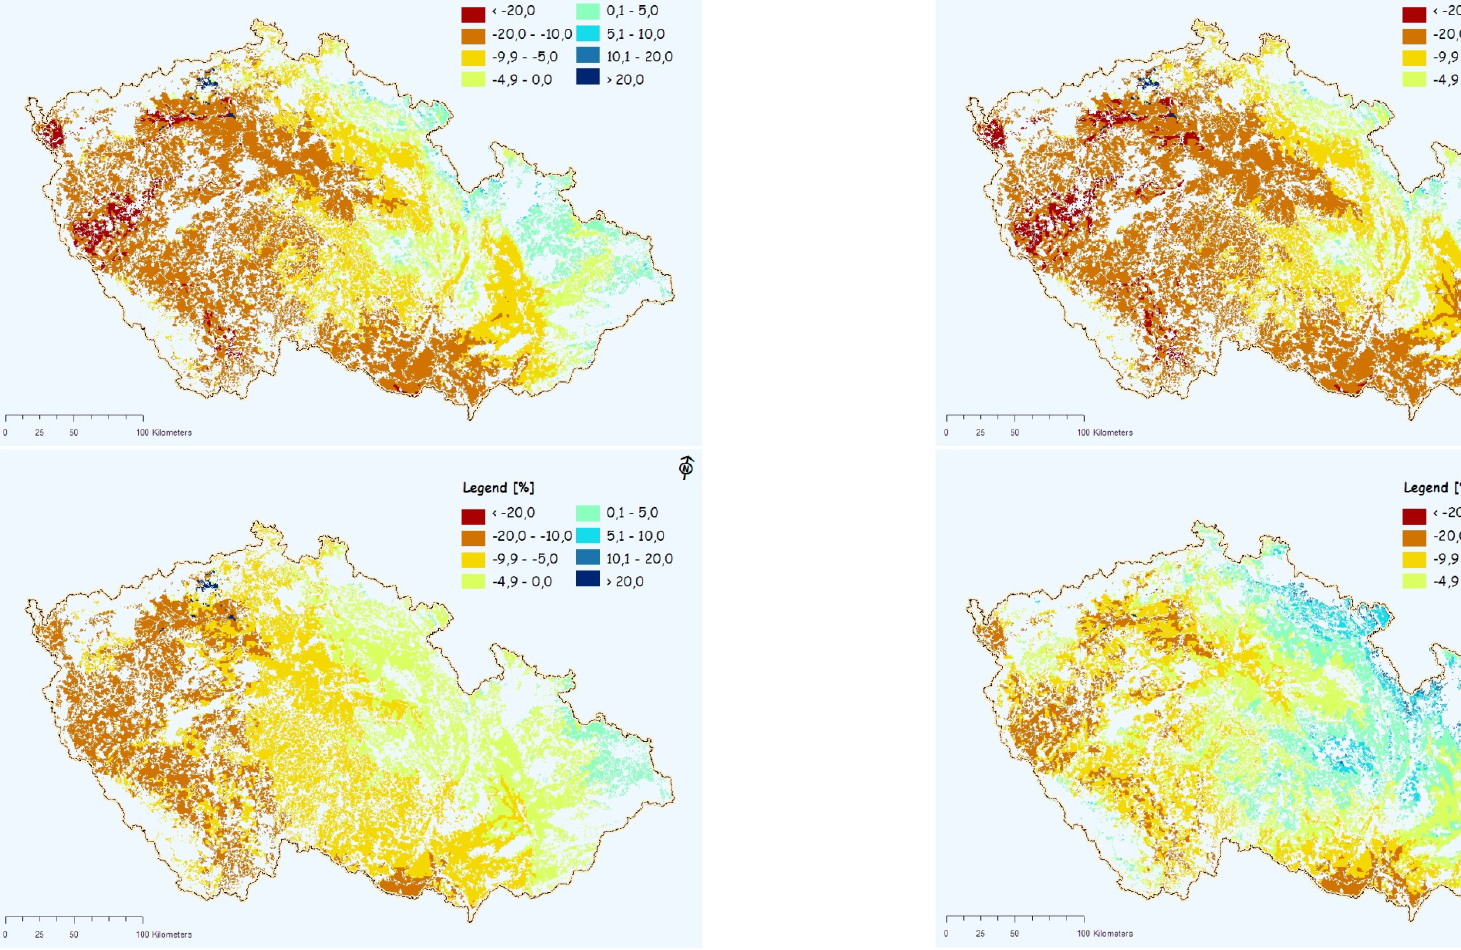
Figure 4. Relative deviations of the winter wheat mean yields (1961-2000) in 1x1 km grids simulated by WOFOST crop model. The mean relative deviation was calculated as relative difference of mean grain yields attained with R estimates based on a) Eq. (4); b) Eq. (5); c) Eq. (6) and d) Eq. (7) and the yield levels simulated G derived by Eq. (1). The Eq. (1) was considered to be the best R estimate when no measured values are available (Trnka et al. , with R G G